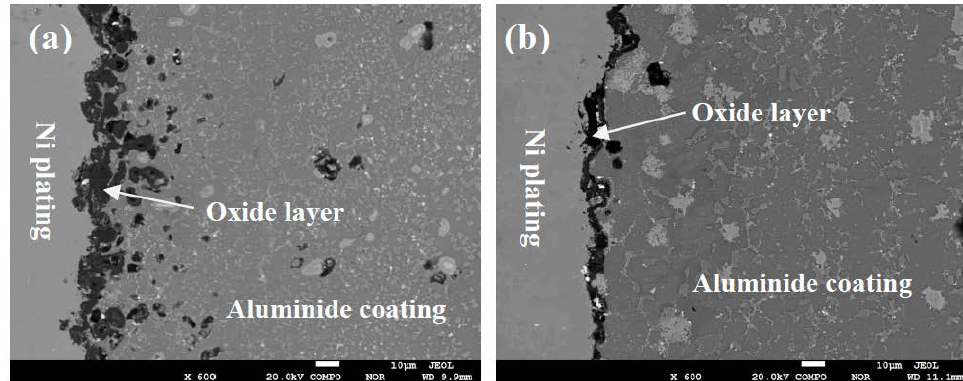
Figure 5. Cross-section SEM images of an aluminide coating on an IN738 superalloy in air and air plus water vapour after being oxidized at 1050 °C for 150 h: ( a ) in air + water vapour, and ( b ) in air.